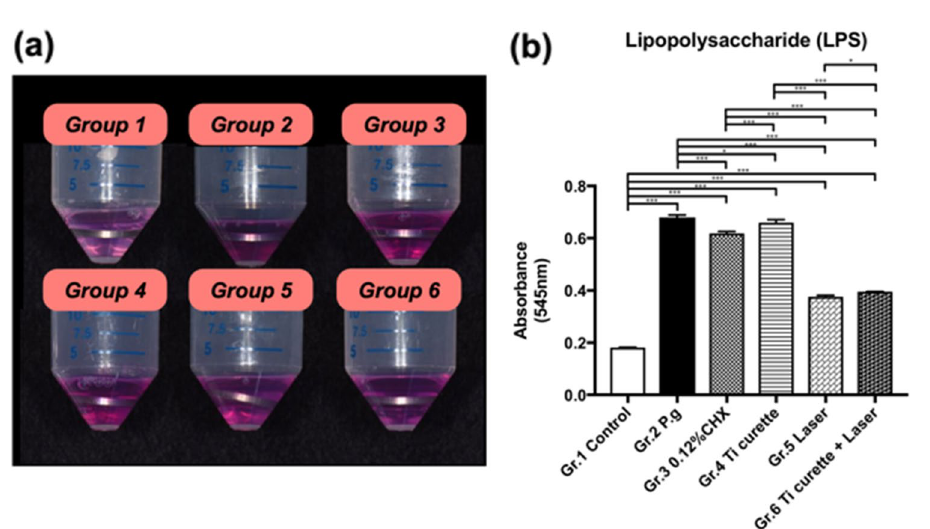
Figure 5. ( a ) Photos of residual LPS observed during the LAL assay of the titanium discs following different surface treatments. ( b ) Ultraviolet (UV) absorbance of the residual LPS on titanium discs following various treatments using UV spectrum absorbance at 545 nm. * p < 0.05 ** p < 0.01 *** p <